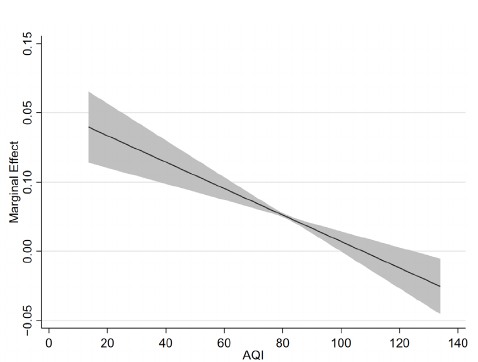
Figure A1. The marginal effect of AQI.